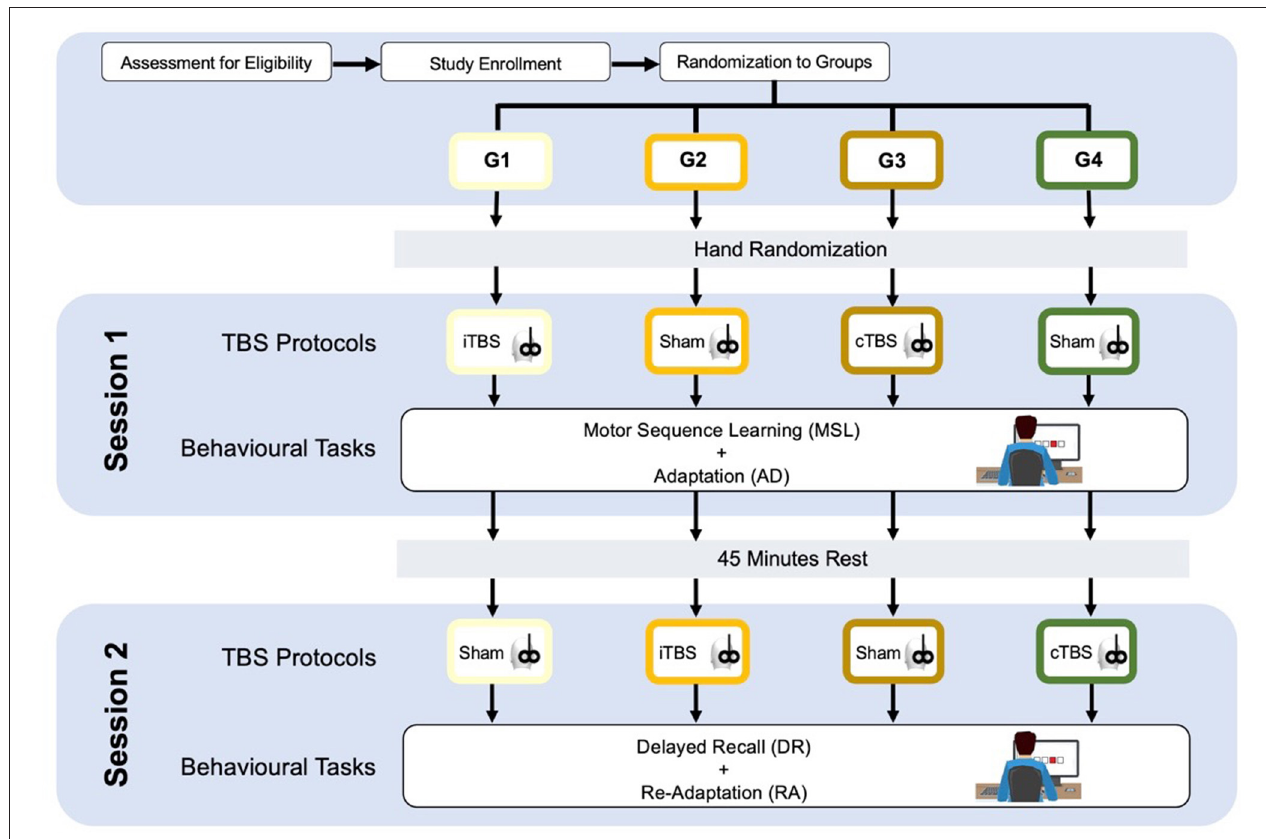
FIGURE 1 | Study design. See the